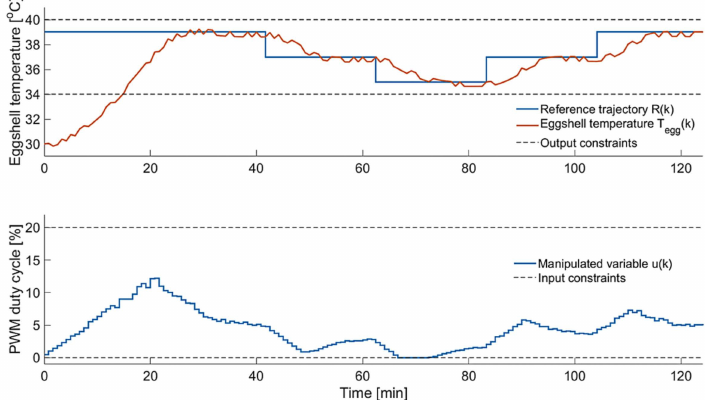
Figure10. Asimulationexampleoftheclosed-loopstepresponse T egg ( k ) (uppergraph)andunmeasured disturbances in both input and output using the designed constrained MPC controller based on the general TF model structure (12), showing the control signal u ( k ) (lower graph). The closed-loop simulation of the developed MPC was implemented on MATLAB on a computer with Intel ® 8 core i7 (2.7 GHz) processor and 16GB RAM. The average computational time for one iteration on this computer was 15.6